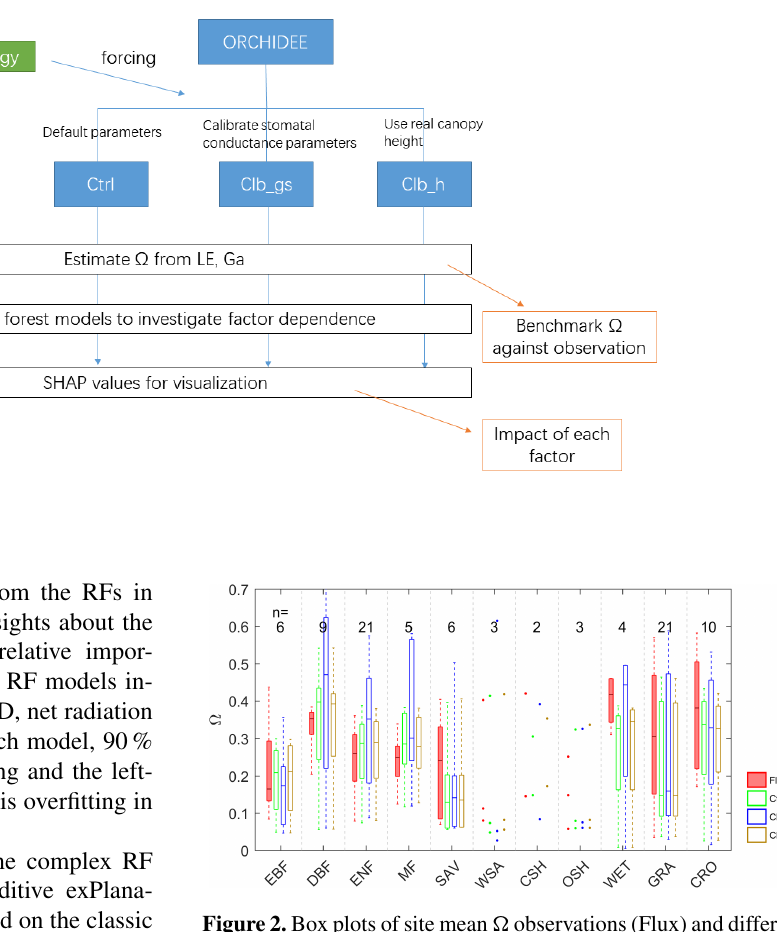
Figure 2. Box plots of site mean (cid:127) observations (Flux) and different simulations; n indicates the number of sites in each PFT group: